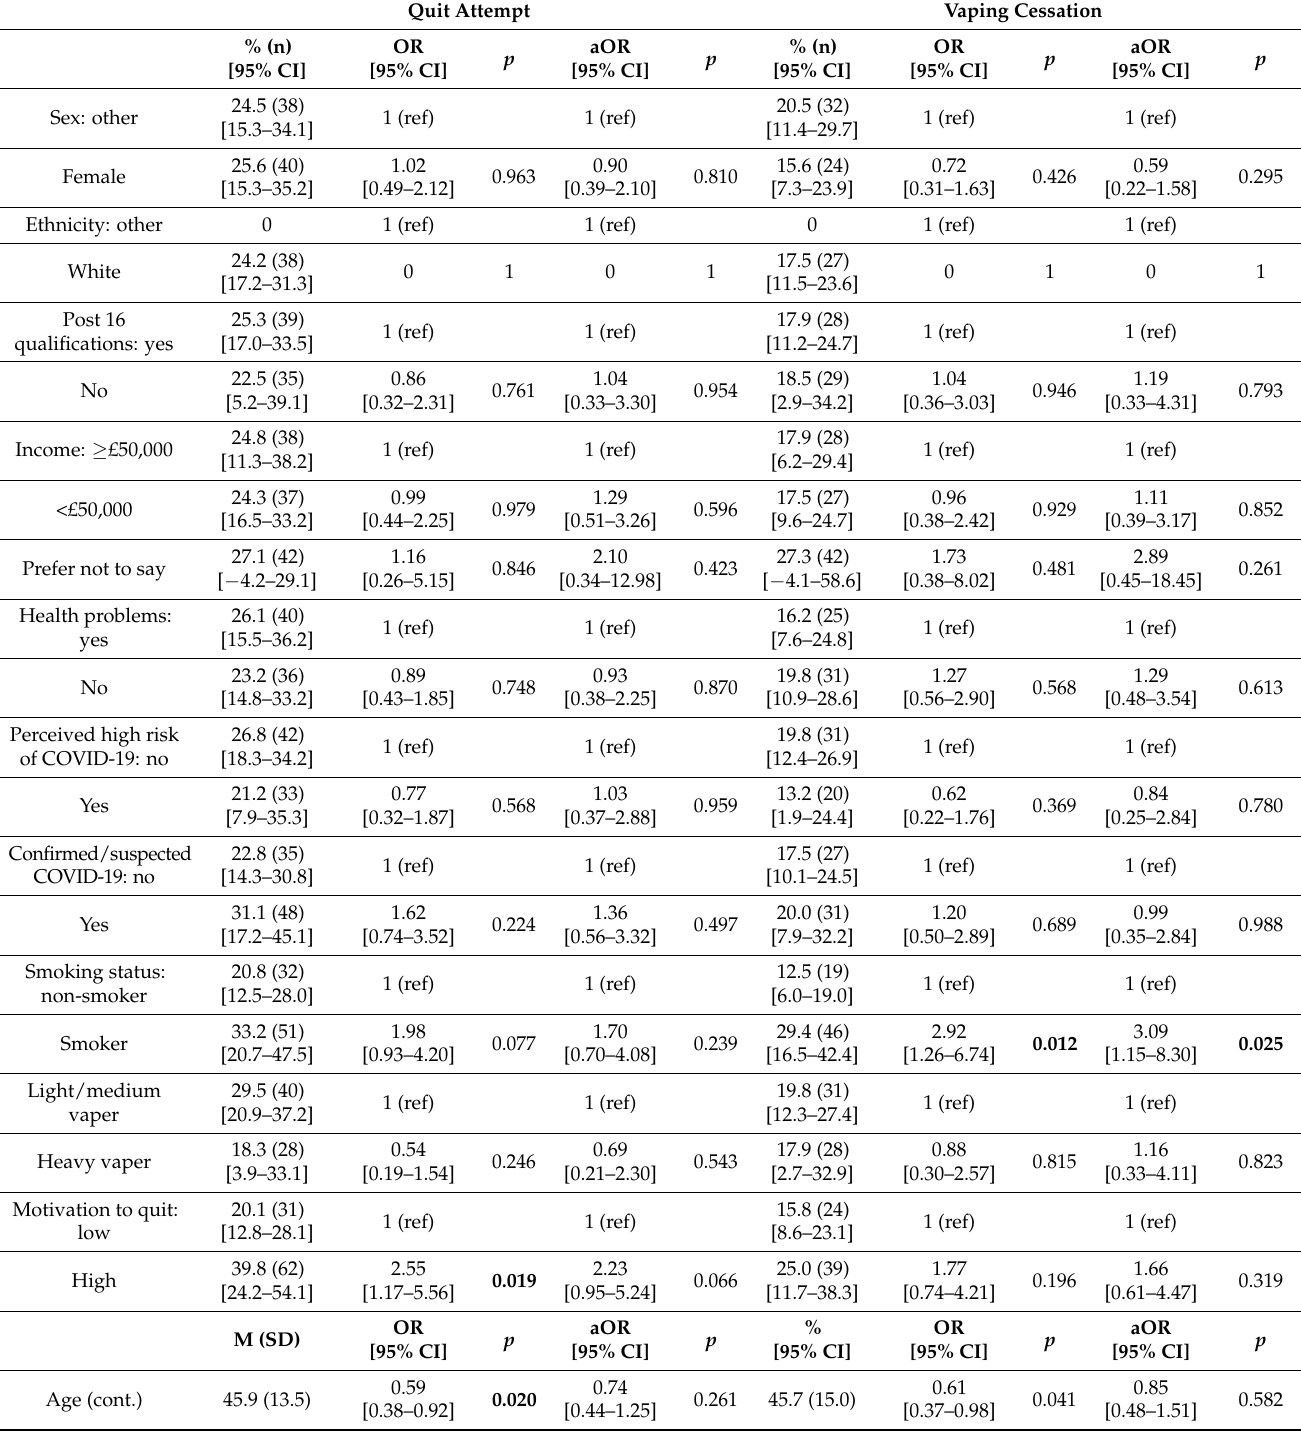
Table 4. Predictors of making a quit attempt and vaping cessation at 12-month follow up among vapers at baseline (N =